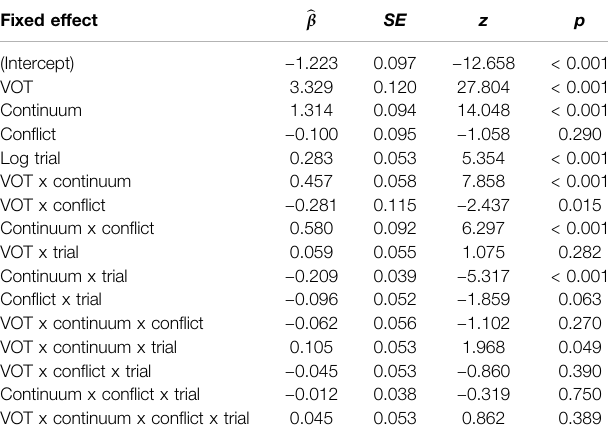
TABLE 1| Results ofthemixedeffects modelfor/k/responsesthatincluded fi xed effects of VOT, continuum, con fl ict, and trial. Fixed